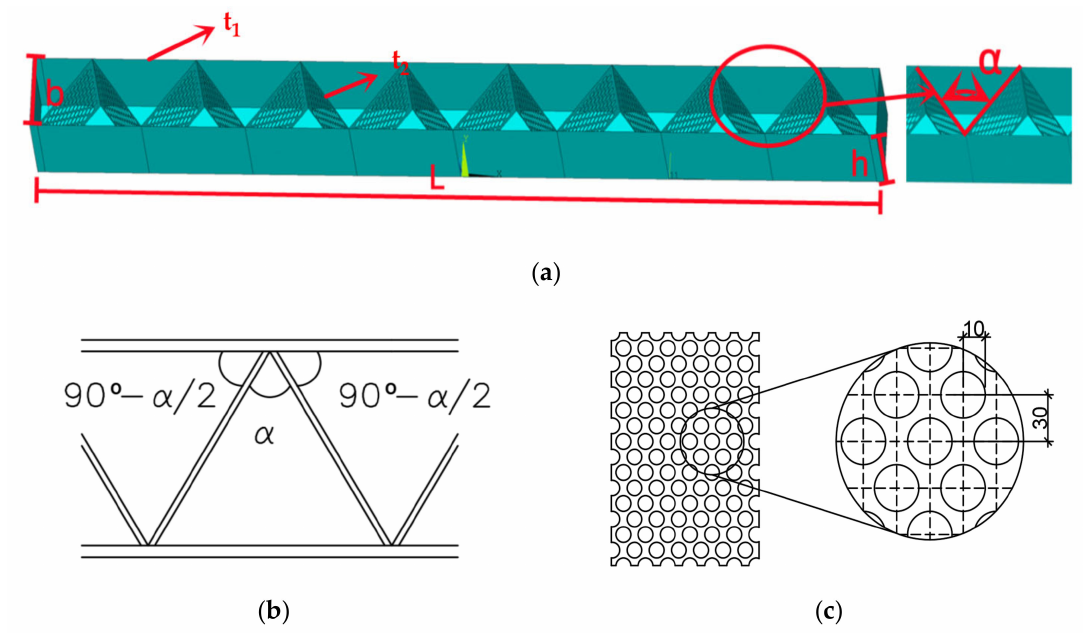
Figure 1. Multi-cavity steel plate: ( a ) Schematic diagram of multi-cavity steel plate frame with partial details; ( b ) Schematic layout of porous steel plate; ( c ) Schematic diagram of pore